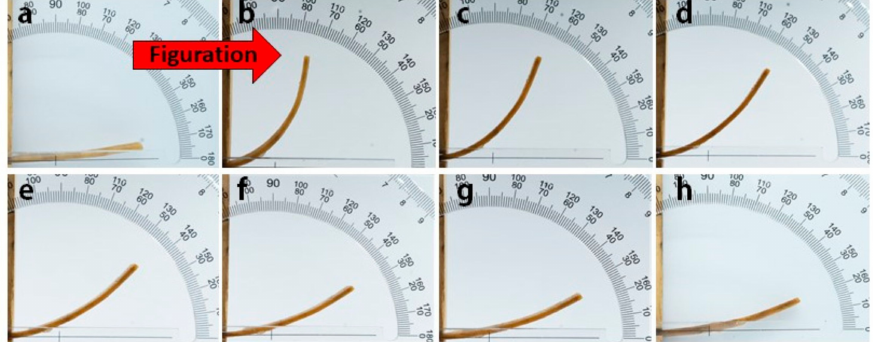
Figure 8. Optical images of SMW deformation process: ( a ) Initial shape of SMW; ( b ) temporary shape of SMW; ( c–h ) the deformation process of SMW.